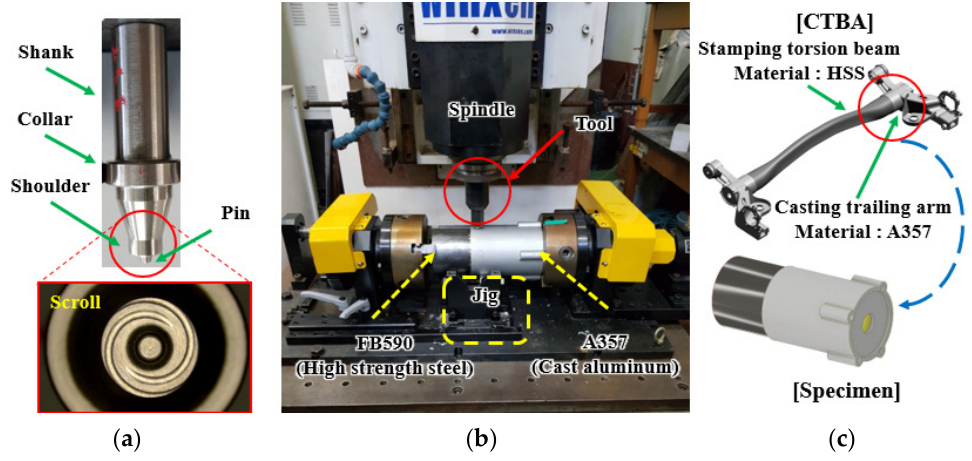
Figure 2. Overall configuration of FSW experiment. ( a ) Photograph of experimental equipment; ( b ) tool and close view of shoulder; ( c ) CTBA and pipe specimen.